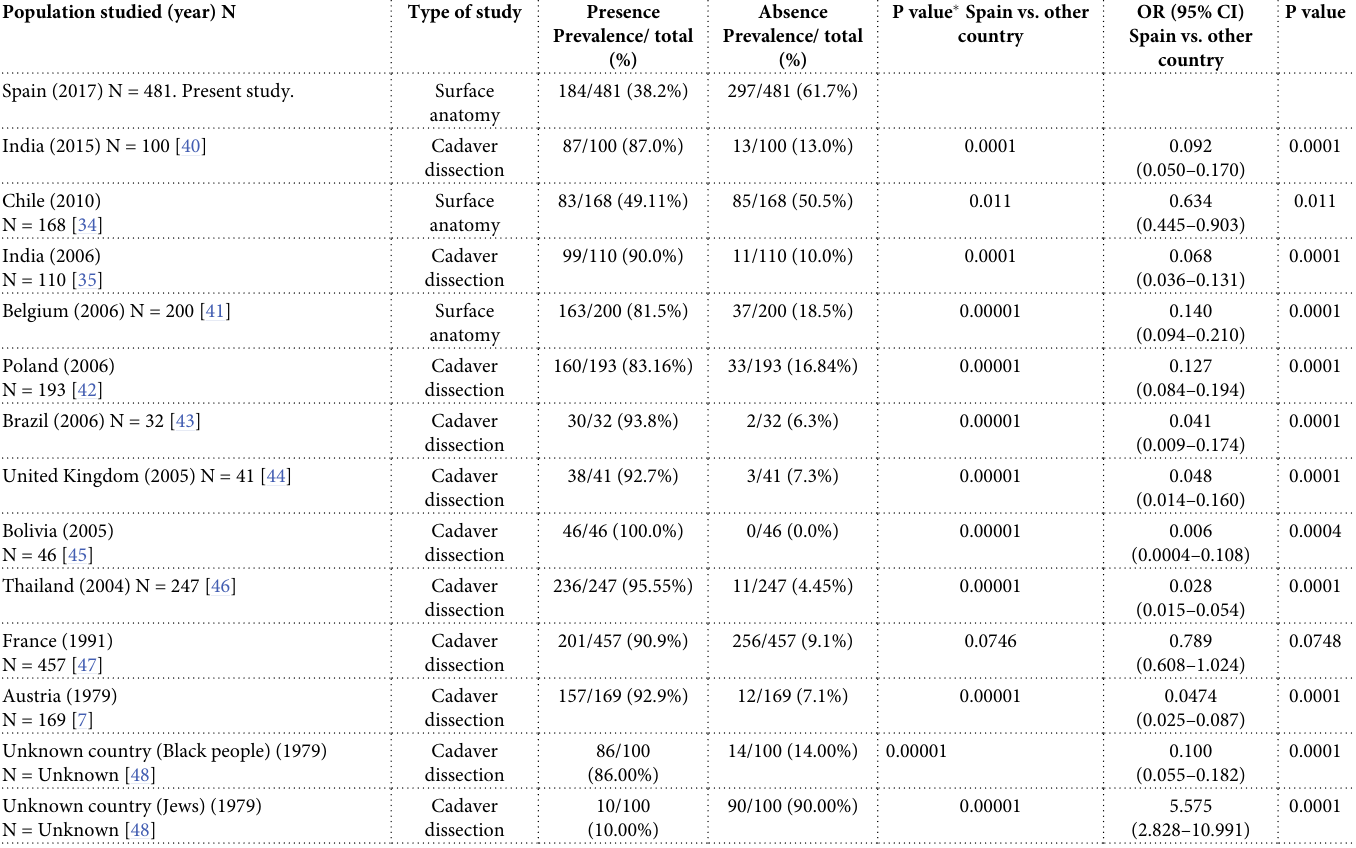
likely to have an absence of the FTM at left foot, with an OR of 1.026 (0.666–1.582; P = 0.786) compared to males, as shown in Table 3. The presence or absence of the FTM in the right and left feet were similar for both sex. A comparison of the presence of the FTM in the Spanish sample with the presence in other samples is shown in Table 4. We found that the presence of the FTM in the Spanish sample Table 4. Comparison of the presence and absence of the fibularis tertius muscle in Spain and other